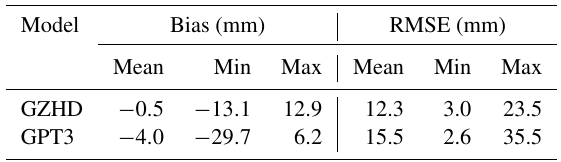
Table 1. Maximum, minimum, and mean of the biases and RMSEs of all the 137 stations shown in the four panels in Fig. 5.